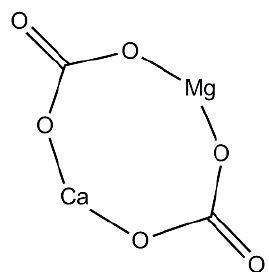
Figure 3. Structure of dolomite.